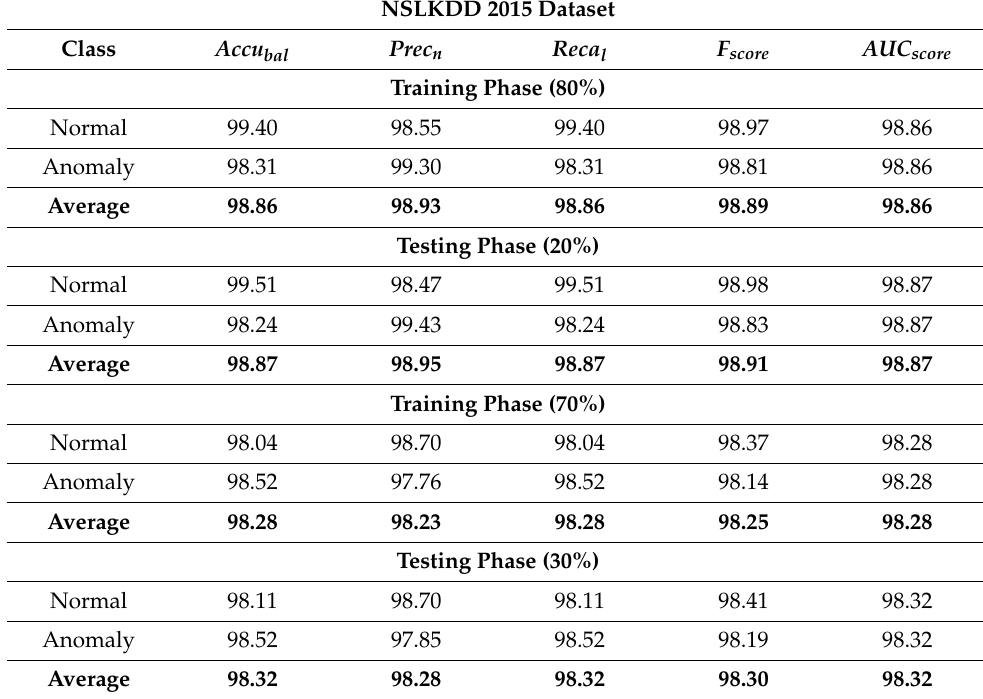
Table 2. Intrusion recognition outcome of XAIID-SCPS system on the NSLKDD2015